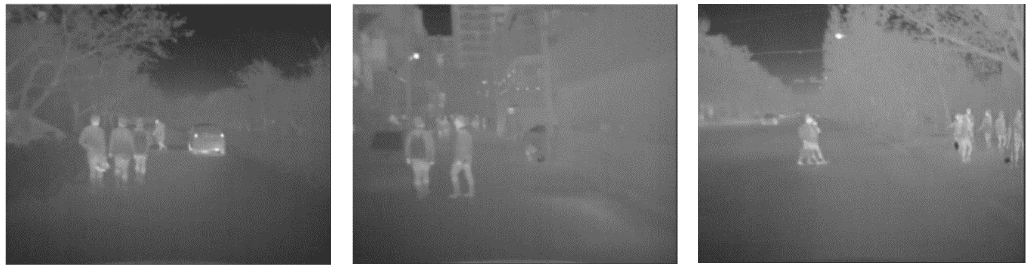
Figure 2. Examples of thermal images in KAIST dataset.